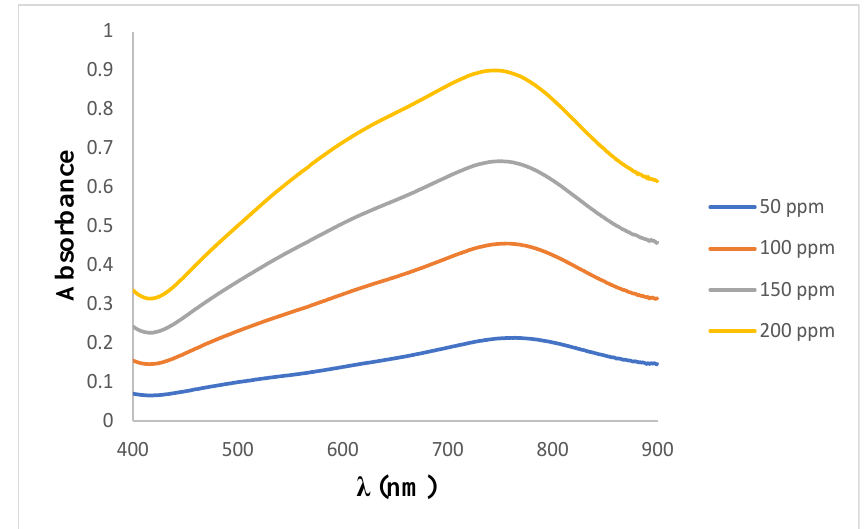
Figure 12. Absorbance as a function of wavelength showing λ max at 750 nm.